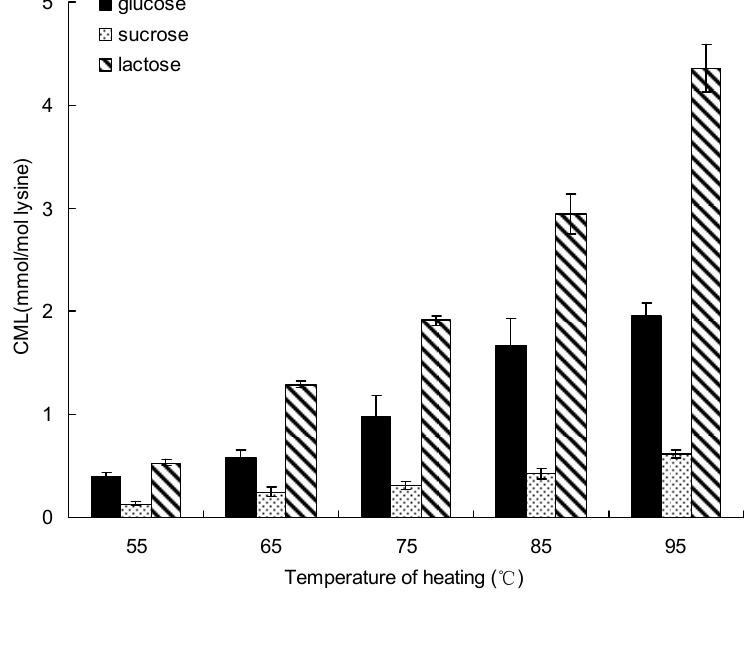
Figure 1. Formation of CML in saccharide-lysine by temperature. Data points are the mean of triplicate measurements ±